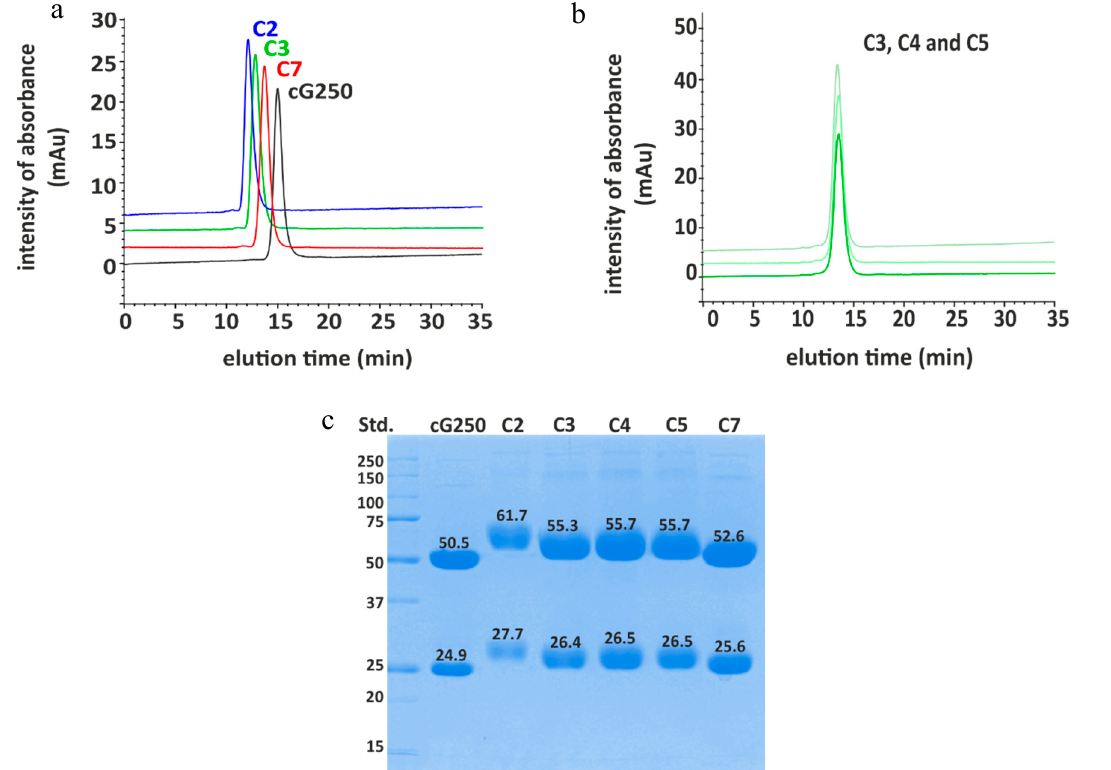
Figure 1. Conjugation of cG250 with DOTA via benzylthiocyano group: ( a ) Size exclusion-high performance liquid chromatography (SE-HPLC) chromatograms of different selected DOTA(SCN)-cG250 conjugates compared to the native cG250; ( b ) size exclusion-high performance liquid chromatography/ultraviolet (SE-HPLC/UV) chromatograms of DOTA(SCN)-cG250 conjugates prepared from the same batch; and ( c ) SDS-PAGE chromatograms of cG250-conjugates in reduced conditions.